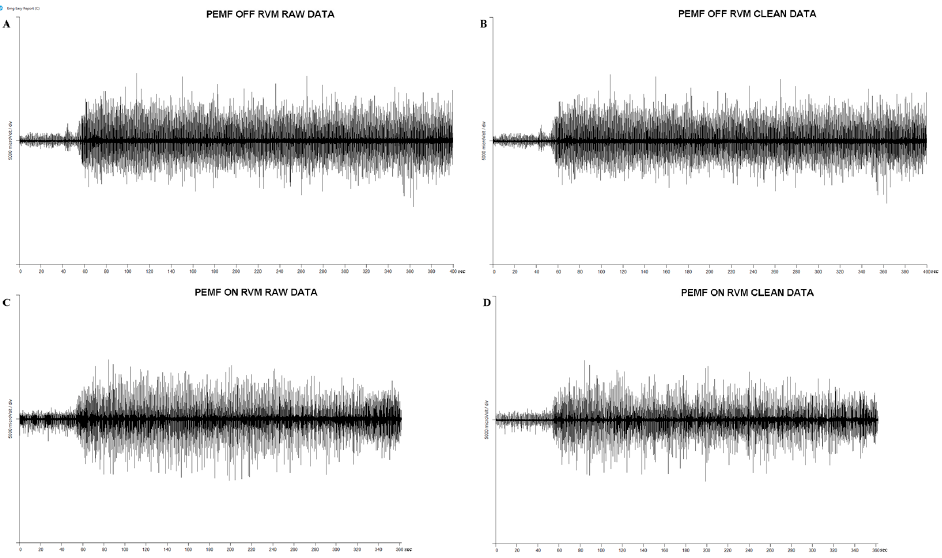
Figure 2. Raw and clean EMG traces for a typical subject in both OFF/ON PEMF stimulation. ( A ) Raw data for a typical muscle (right vastus medialis) during PEMF OFF stimulation. ( B ) Clean data for a typical muscle (right vastus medialis) during PEMF OFF stimulation: we used a wavelet-based de-noising filter in order to reduce background noise and automatically remove large and frequent artifacts on EMG traces. ( C ) Raw data for a typical muscle (right vastus medialis) during PEMF ON stimulation. ( D ) Clean data for a typical muscle (right vastus medialis) during PEMF ON stimulation: after wavelet-based de-noising filter, we used a consolidation process and a specific algorithm in order to remove PEMF